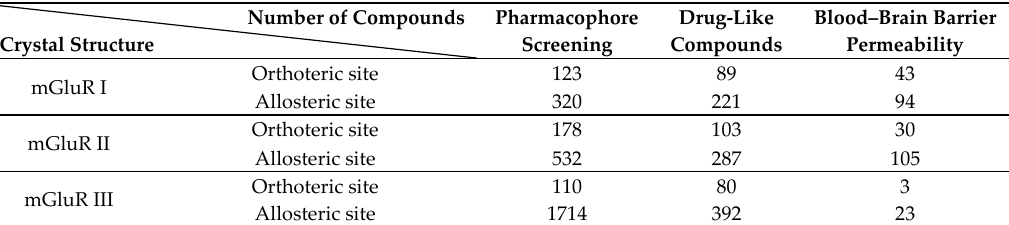
Table 3. The results of database search.